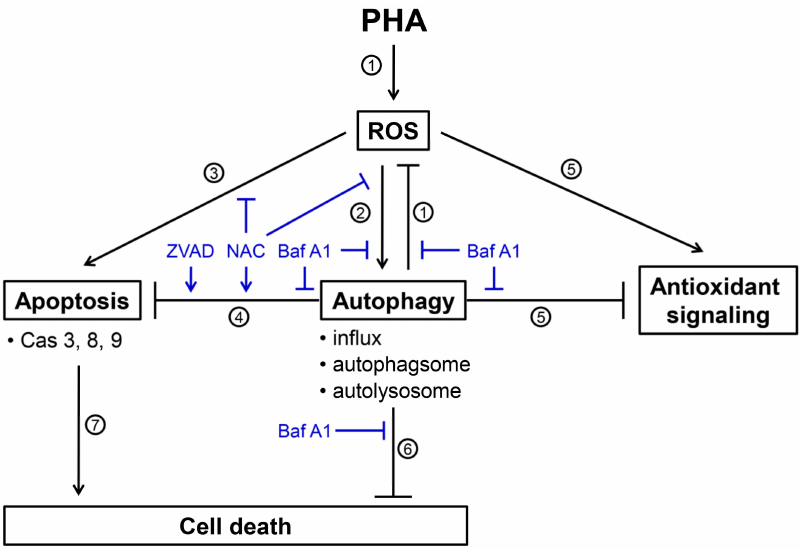
Figure 8. Scheme for illustrating the PHA-induced ROS, cytoprotective autophagy, and apoptosis of breast cancer cells. Several events were mentioned as follows. ( 1 ) PHA induces ROS generations and Baf A1 (autophagy inhibitor) inhibits autophagy-suppressed ROS to increase ROS levels (Figure 4), suggesting that autophagy exerts antioxidant effects. ( 2 ) PHA-induced ROS generation stimulates autophagy by increasing autophagy influx, autophagosome, and autolysosome (Figures 2 and 3). These PHA-stimulated autophagy changes were suppressed by NAC (ROS inhibitor) and Baf A1 (Figures 2 and 3), supporting the involvement of ROS and autophagy in this regulation. ( 3 ) PHA causes apoptosis associated with annexin V increment and caspases 3, 8, and 9 activations (Figures 6 and 7). NAC suppresses PHA-induced apoptosis, demonstrating this apoptosis induction is ROS-dependent. ( 4 ) This PHA-stimulated autophagy suppresses apoptosis, as supported by the evidence that Baf A1 induces apoptosis (Figures 6 and 7). This apoptosis-suppressing effect of PHA-stimulated autophagy is also activated by NAC and ZVAD (apoptosis inhibitor), supporting the involvement of ROS in this regulation. ( 5 ) PHA-stimulated autophagy suppresses antioxidant signaling, supported by the finding that antioxidant signaling is upregulated by Baf A1 (Figure 5). This upregulation of antioxidant signaling may be a stress response to ROS. ( 6 ) PHA-stimulated autophagy is cytoprotective because Baf A1 enhances the cytotoxicity of PHA in breast cancer cells (Figure 1). ( 7 ) Finally, PHA-induced apoptosis contributes to cell death of breast cancer cells [12]. Taken together, PHA induces ROS to promote cytoprotective autophagy, which limits its-mediated apoptosis of breast cancer